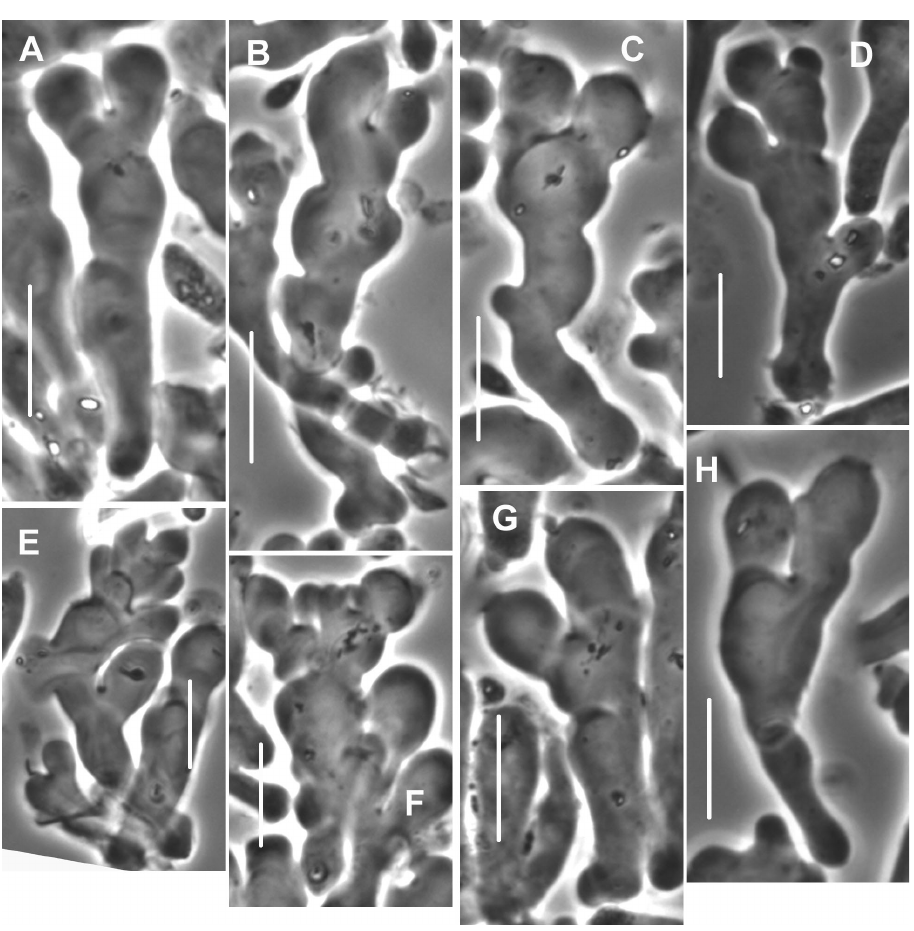
Figure 90. Mycetinis yunnanensis . Cheilocystidia. A-C, G, H Dichotomously lobate individuals D–F Multilobate individuals. Note beaked or pseudosterigmate apices in B, D, F–H. Standard bars = 10 µm. TFB 3145 (TENN-F-